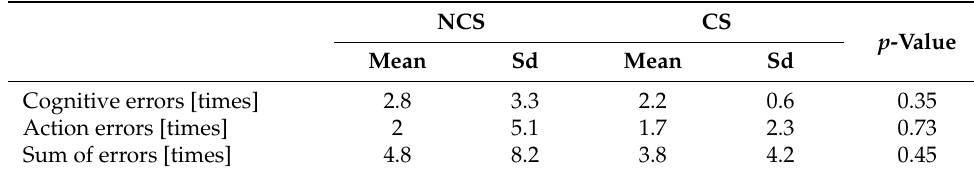
Table 4. Dual tasks performance of NCS and CS groups.